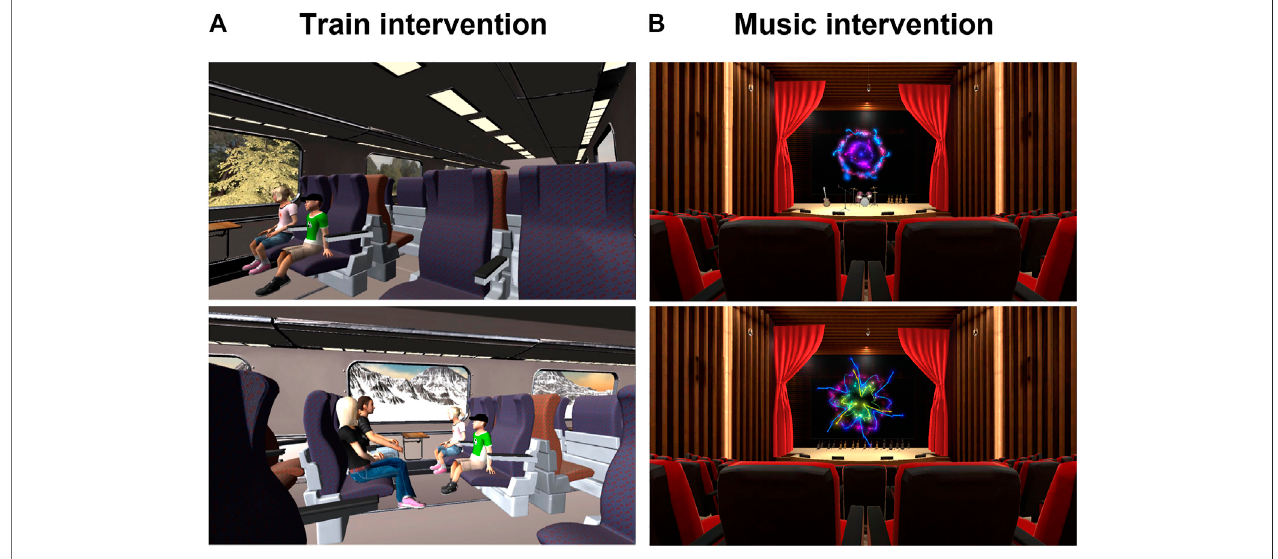
FIGURE 1 | Virtual train and music theatre. Examples of what a user can experienced when immersed in the virtual train (A) or the virtual music theatre (B) .